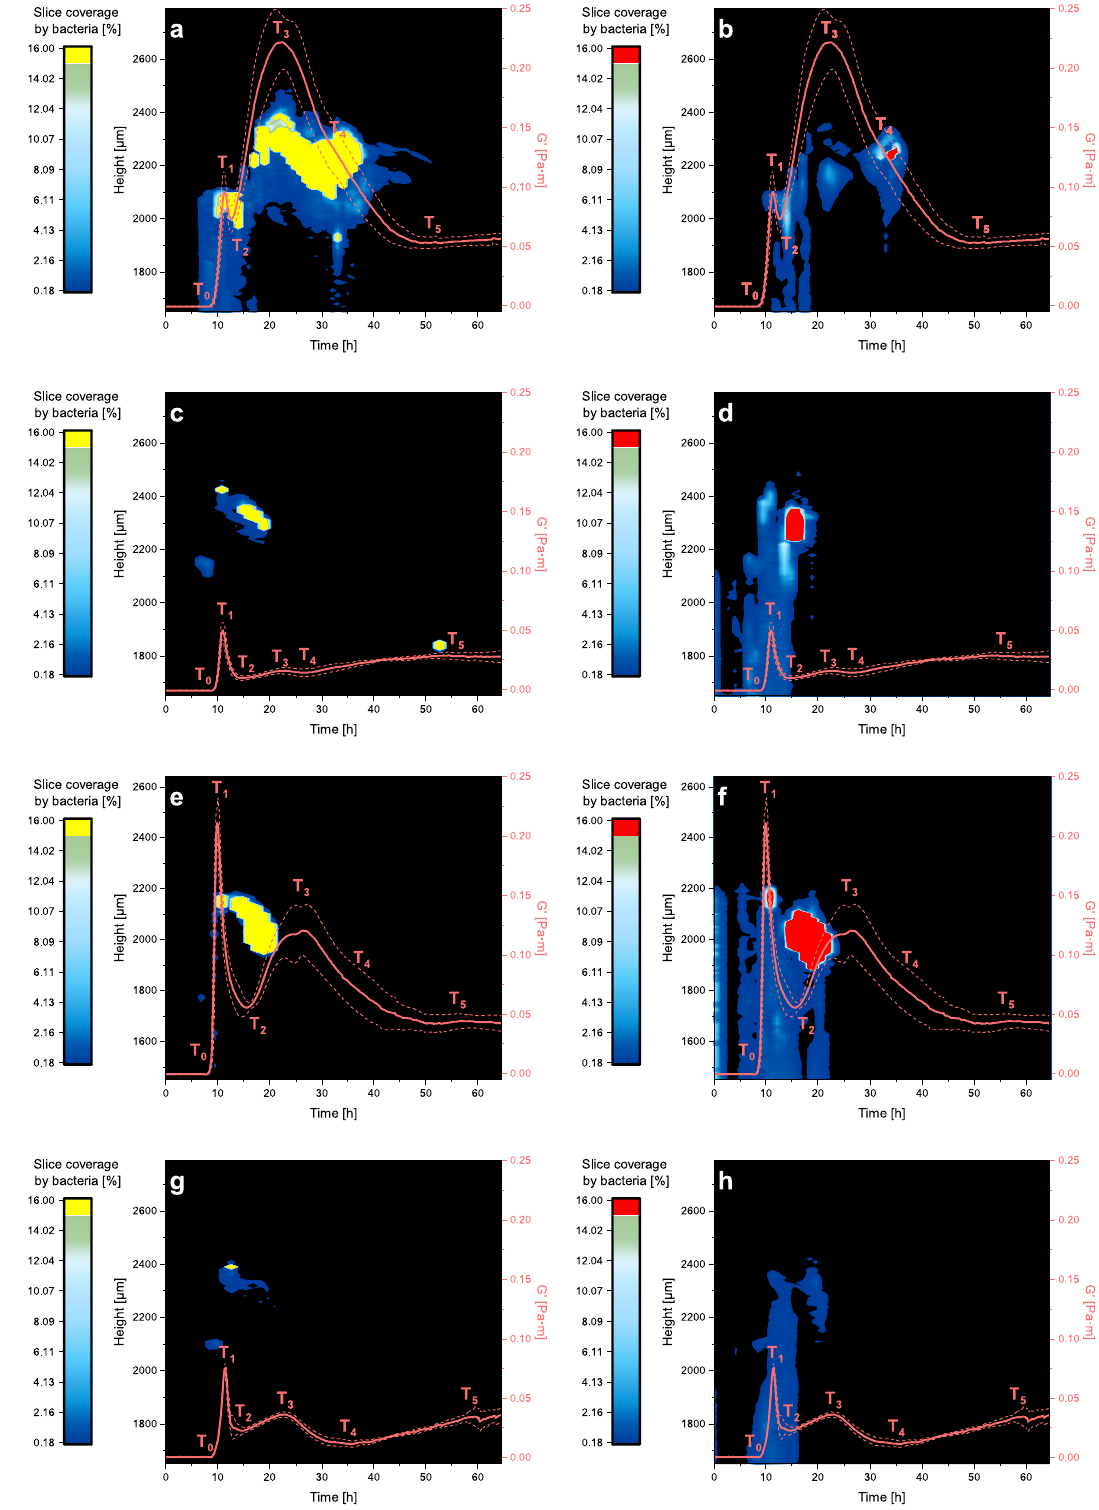
Fig. 2 The correlation between storage modulus and vertical bacterial density at the water – air interface. The images are presented as a combination of data obtained by CLSM and interfacial rheology method showing both viable ( a , c , e , g ) and dead cells ( b , d , f , h ) for B. subtilis PS-216 wild type strain ( a , b ), Δ tasA ( c , d ), Δ epsA-O ( e , f ) and Δ epsA-O Δ tasA ( g , h ) mutant. Values above 16% are in the same colour. T 0 – T 5 denotes key event points where a drastic change in viscoelastic behaviour occurred. In tasA mutant and in the double mutant, the in fl ection point T 4 turned into the second minima. Viscoelastic curves are presented as mean ± standard deviation from 3 to 6 independent biological measurements. One of 3 – 6 qualitatively similar replicates of vertical bacterial density is